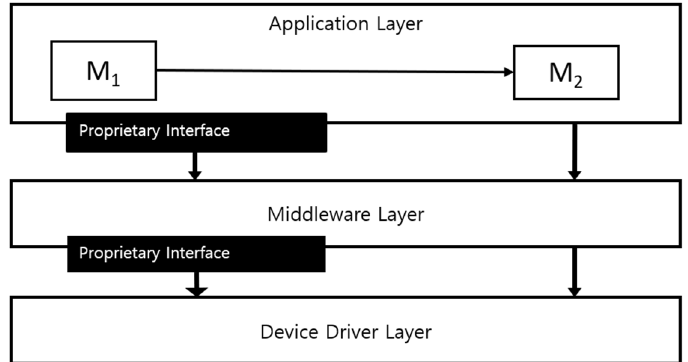
Figure 2. The proprietary interface between layers and its modules.